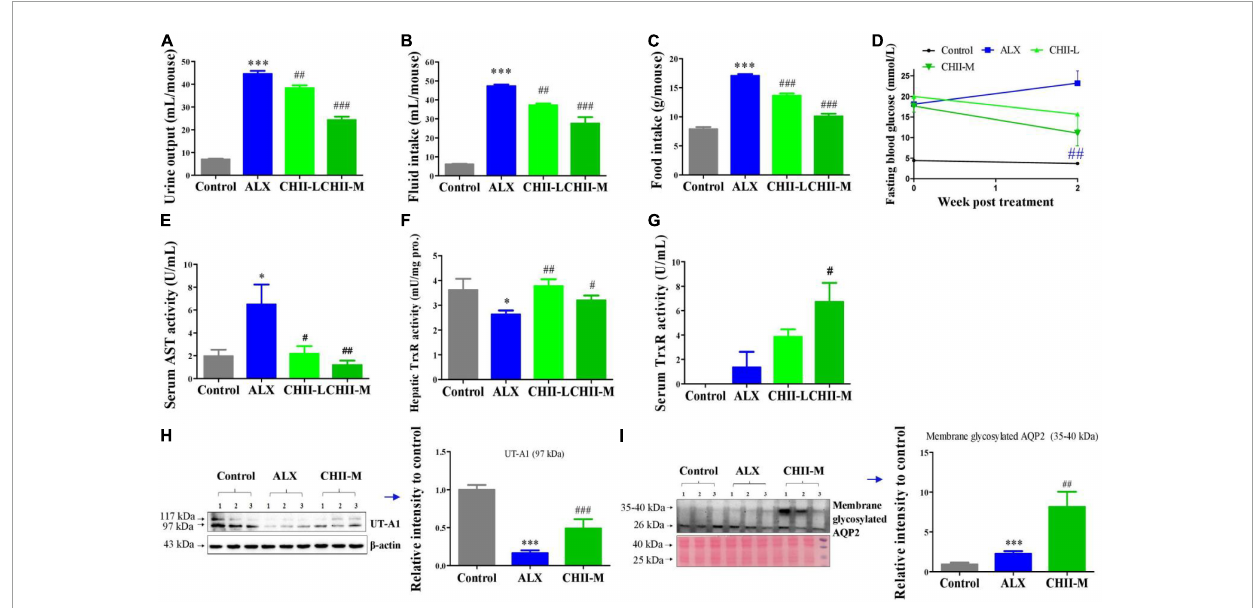
FIGURE2 Effect and mechanism of short-term intake of CHII (1/20, 1/40, m/v) on symptoms of diabetes in ALX-induced type 1 diabetic mice. Treatments were introduced in animal experiment 2. (A–C) Urine output and fluid and food consumptions. (D) Fasting blood glucose. (E) AST in serum. (F,G) Enzyme activity levels of TrxR in liver and serum. (H,I) Protein levels of UT-A1 and membrane glycosylated AQP2 in kidney. ∗ p < 0.05, ∗∗∗ p < 0.001, compared to control. # p < 0.05, ## p < 0.01, ### p < 0.001, compared to ALX. NS, p > 0.05. Data are presented as mean ± SEM ( n =